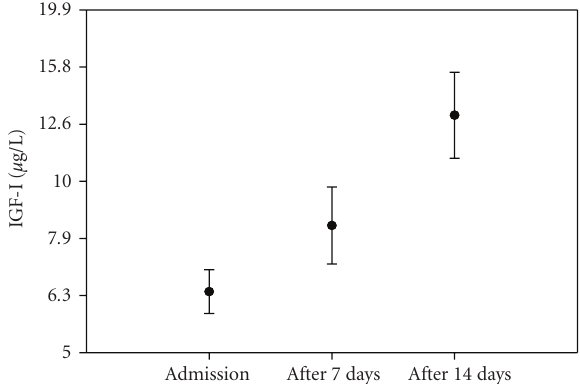
Figure 1: Increase in IGF-I during nutritional rehabilitation in 59 children admitted for malnutrition in Burkina